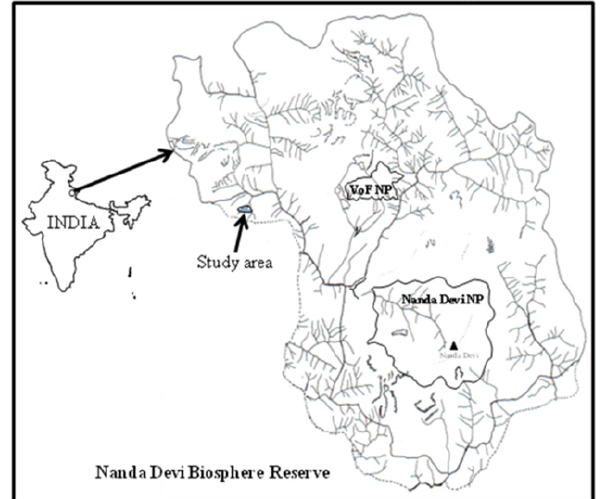
Fig. 1. Location of study area in Nanda Devi Biosphere Reserve,